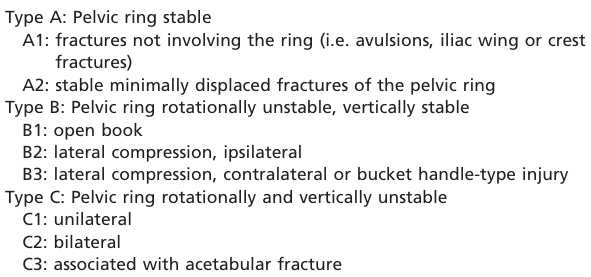
Table 1 - Tile Classification of pelvic ring